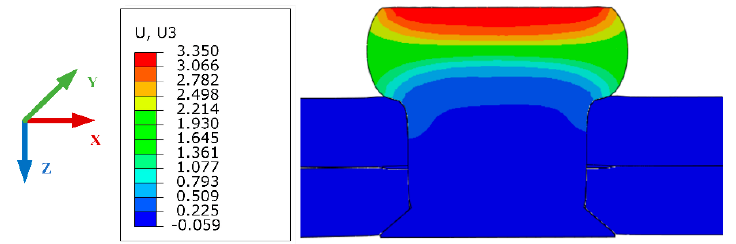
Figure 9. Deformation of 1# rivet in group 2-5-4 in Z-direction.